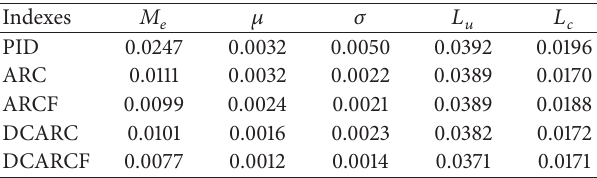
Table 2: Performance indexes during the last two seconds in slow tracking case.